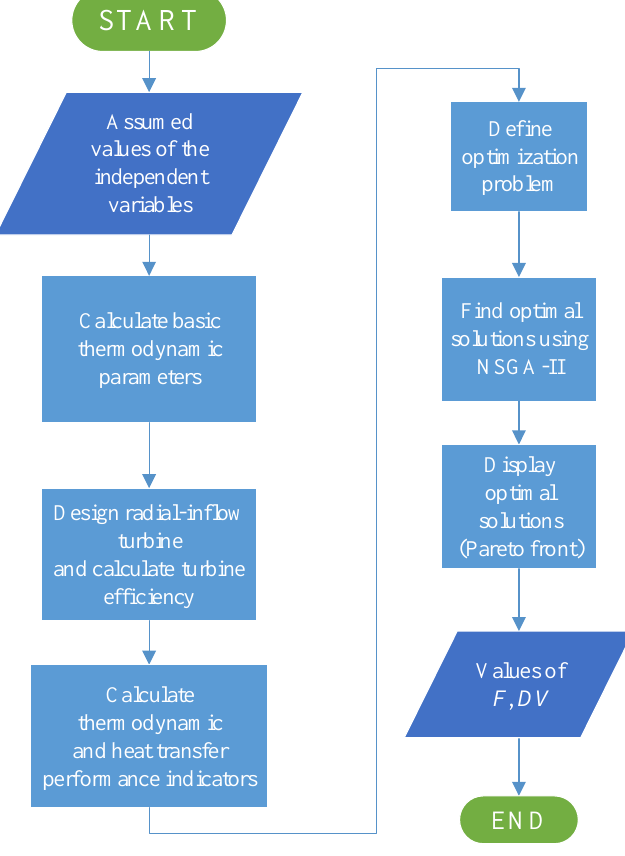
Figure 3. Flowchart of calculation steps.